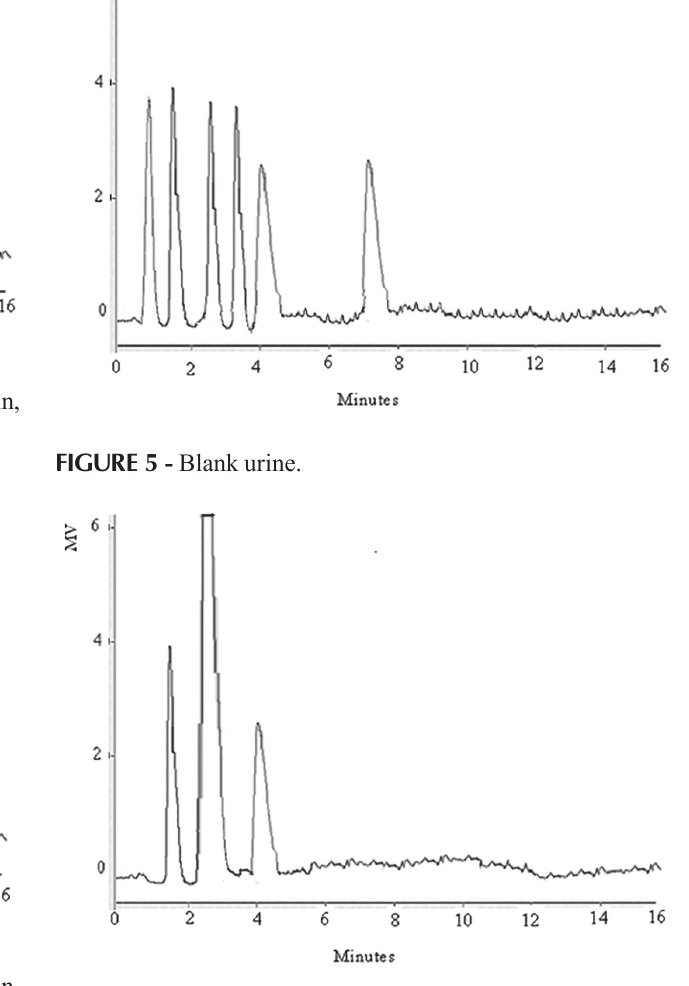
FIGURE 3 - Chromatogram in Urine samples.1=Metformin, 2=Sitagliptin, 3= Rosiglitazone, 4=Pioglitazone, 5=Glimepiride.